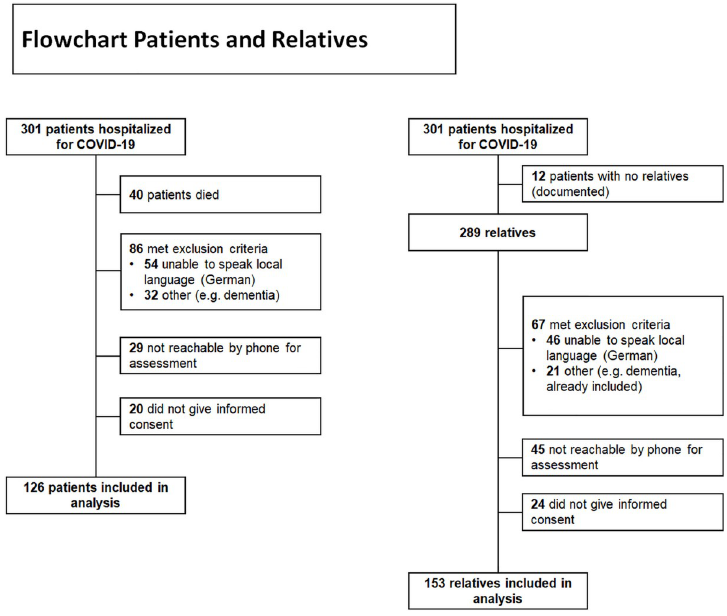
Fig 1. Flow diagram of the study population. Legend: Flow diagram illustrating inclusion and exclusion of eligible participants.